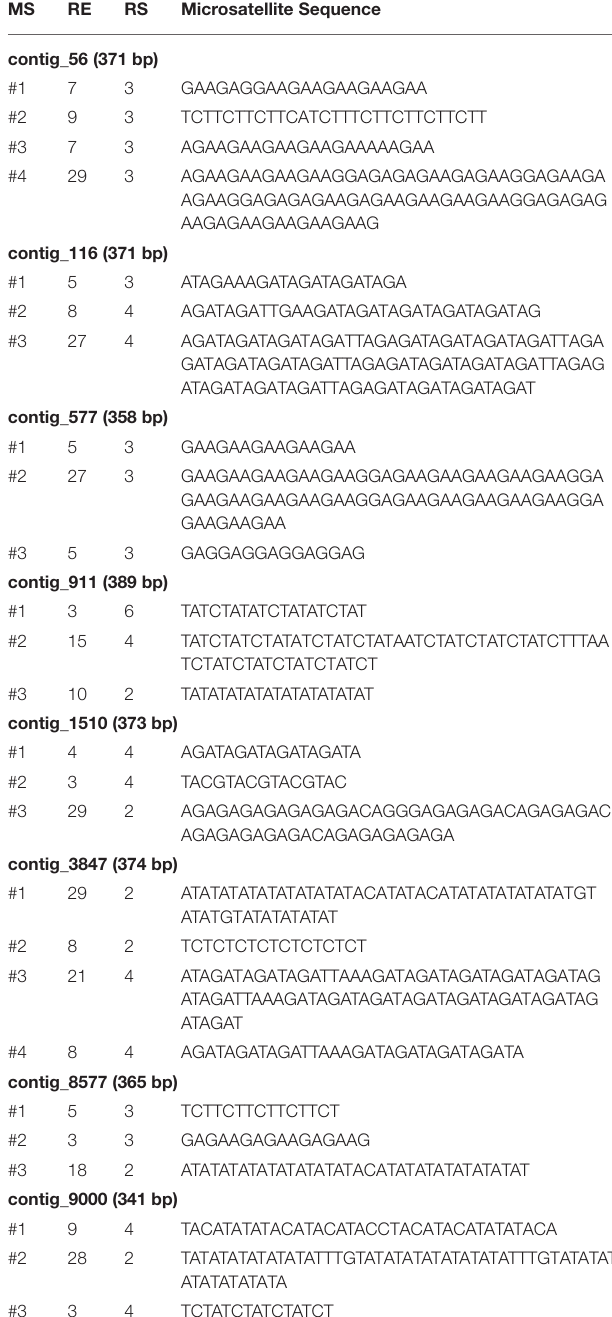
TABLE 2 | Contigs (with region sizes), microsatellites (MS, numbered for each contig), numbers of replicates (RE), repeat sizes (RS) [in bp], and included microsatellite